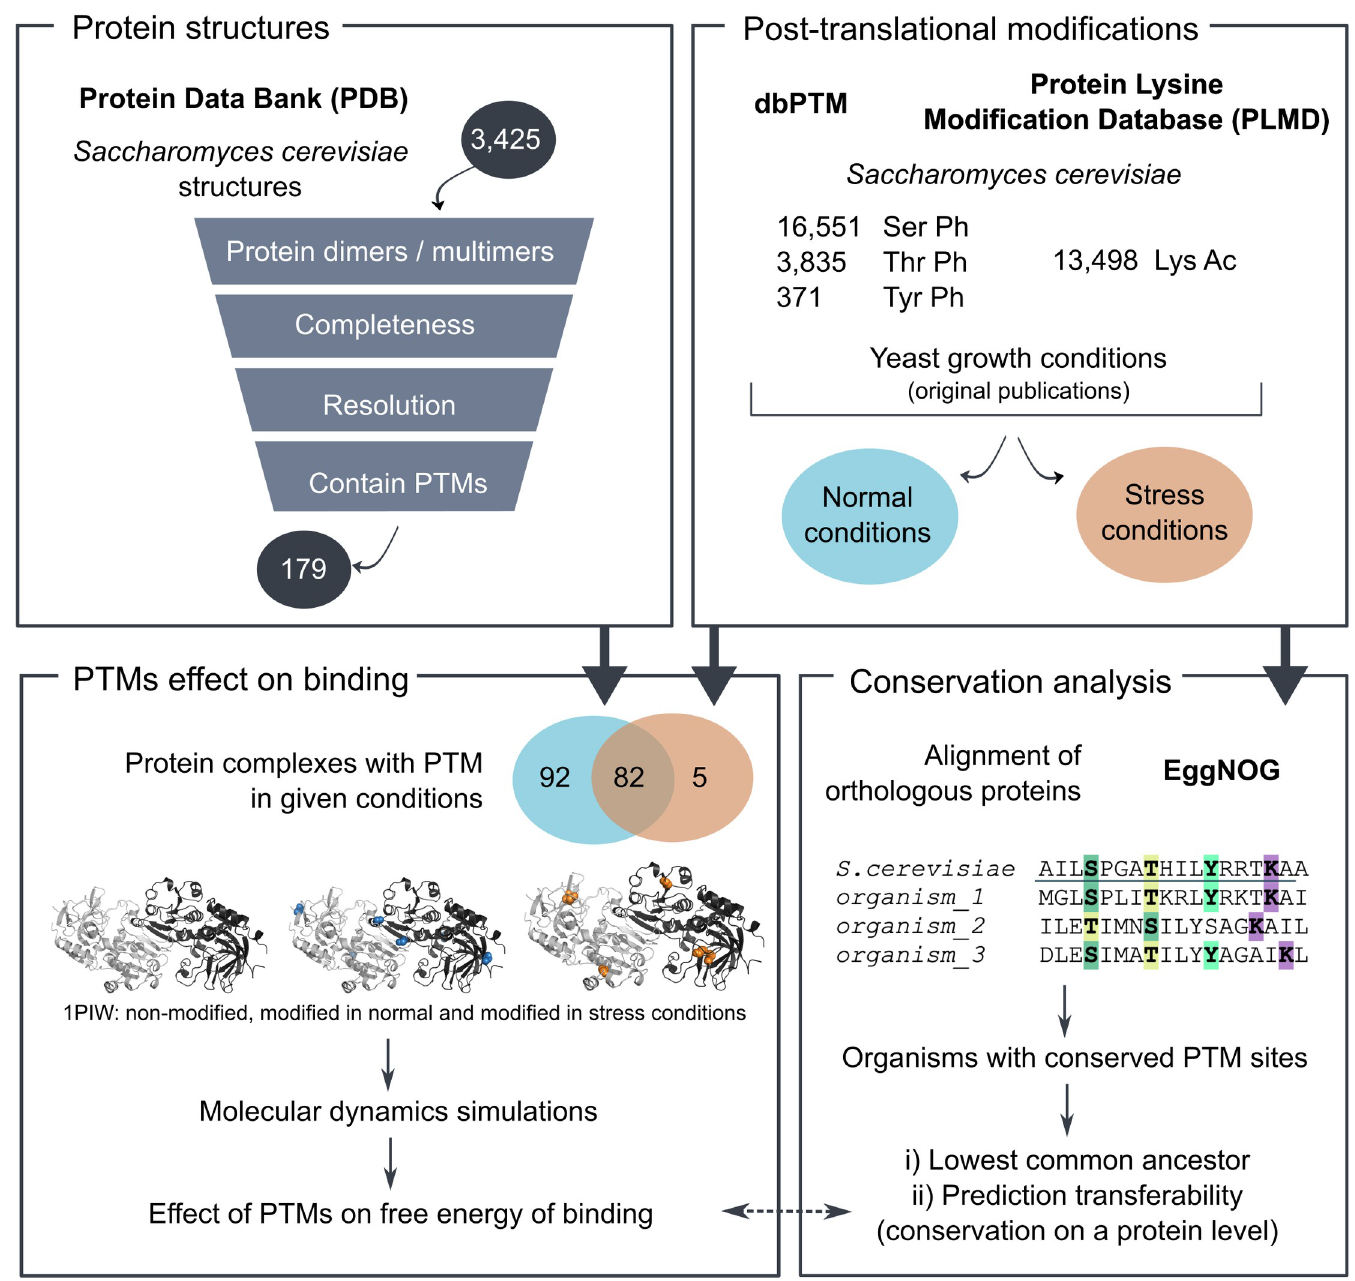
Fig 1. Workflow overview. The publicly available yeast protein structures were combined with PTM sites data in order to assess the effects of PTMs on protein binding. In addition, conservation analysis aided in identifying the subset of predictions that are transferable to protein-protein interactions in other